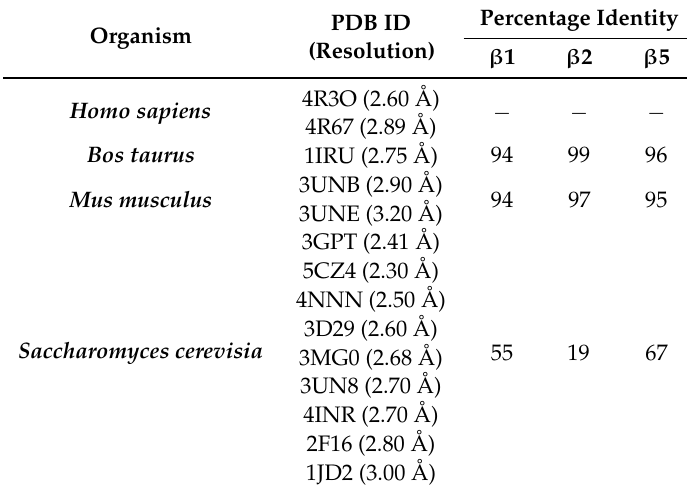
Table 2. Examples of PDB ID of different organisms and identity percentage when compared to the human